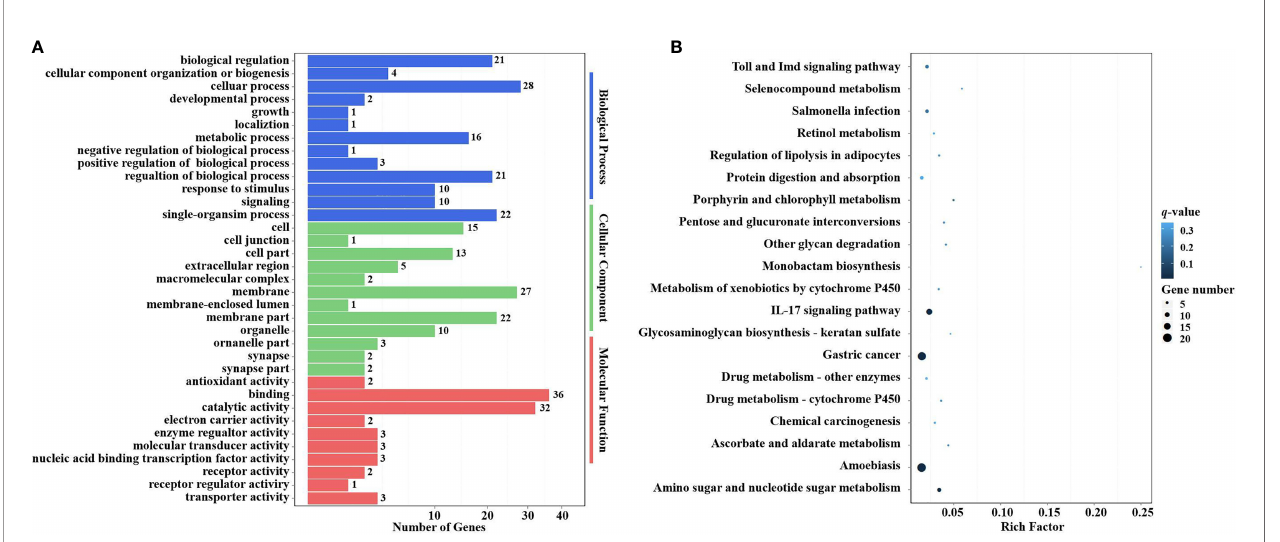
FIGURE 9 | GO terms and KEGG pathway enrichment analyses of target DEGs of DEMs. (A) GO term enrichment analysis of target DEGs of DEMs. Three main GO categories: biological process, cellular component, and molecular function. The x-axis indicates the number of genes, and the y-axis indicates the GO terms (level 2). (B) Top 20 KEGG pathway enrichment of DEG genes of DEMs (level 3). The x-axis indicates the ratio of the number of genes in the DEGs, and the y- axis indicates the pathways. GO, Gene Ontology; KEGG, Kyoto Encyclopedia of Genes and Genomes; DEGs, differentially expressed genes; DEMs, differentially expressed